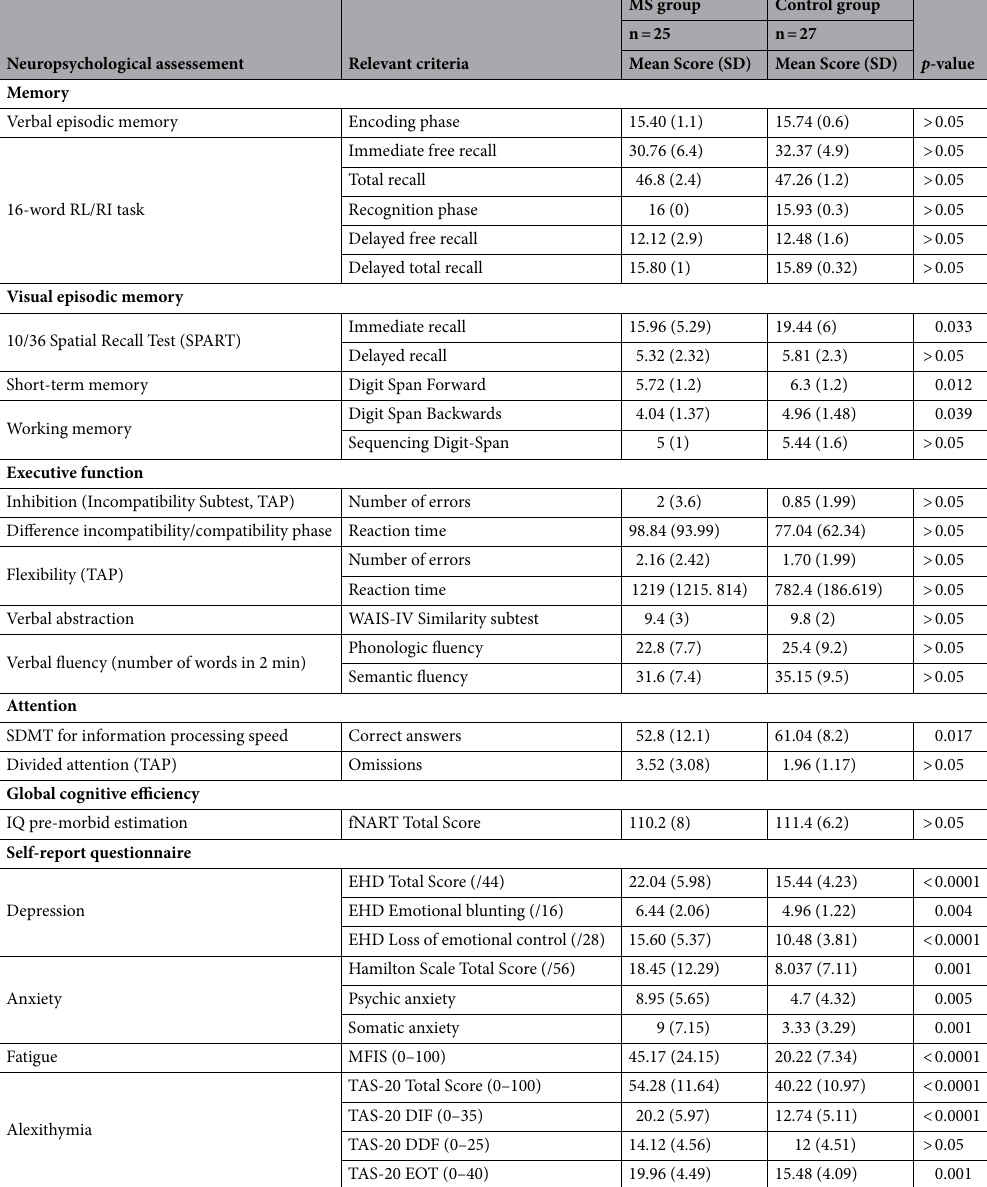
Table 3. Cognitive assessment and self-report questionnaire: comparison of results for the MS group and the control group. 16 word RL/RI task 16 word free recall/cued recall task, TAP test of attentional